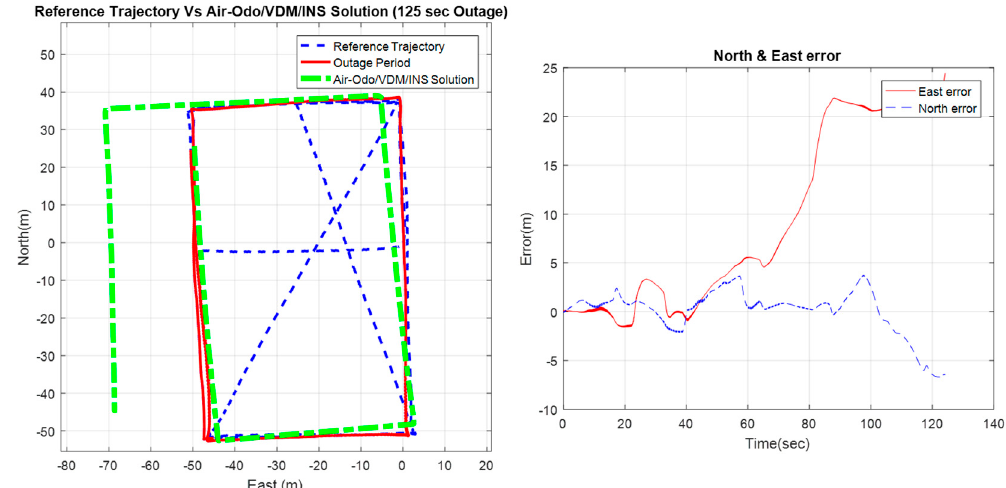
Figure 15. Air-Odo/vehicle dynamic model/INS integration performance during 125 s of complete GNSS signal outage.